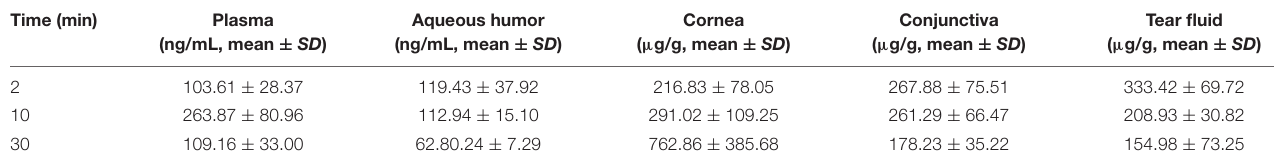
TABLE 2 | Concentration of TSA in tissues and plasma after topical application in eye ∗